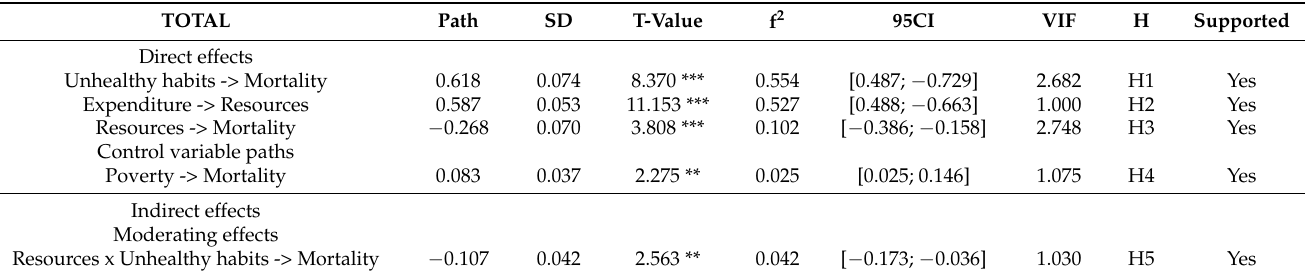
Table 4. Path coefficients (b) and statistical